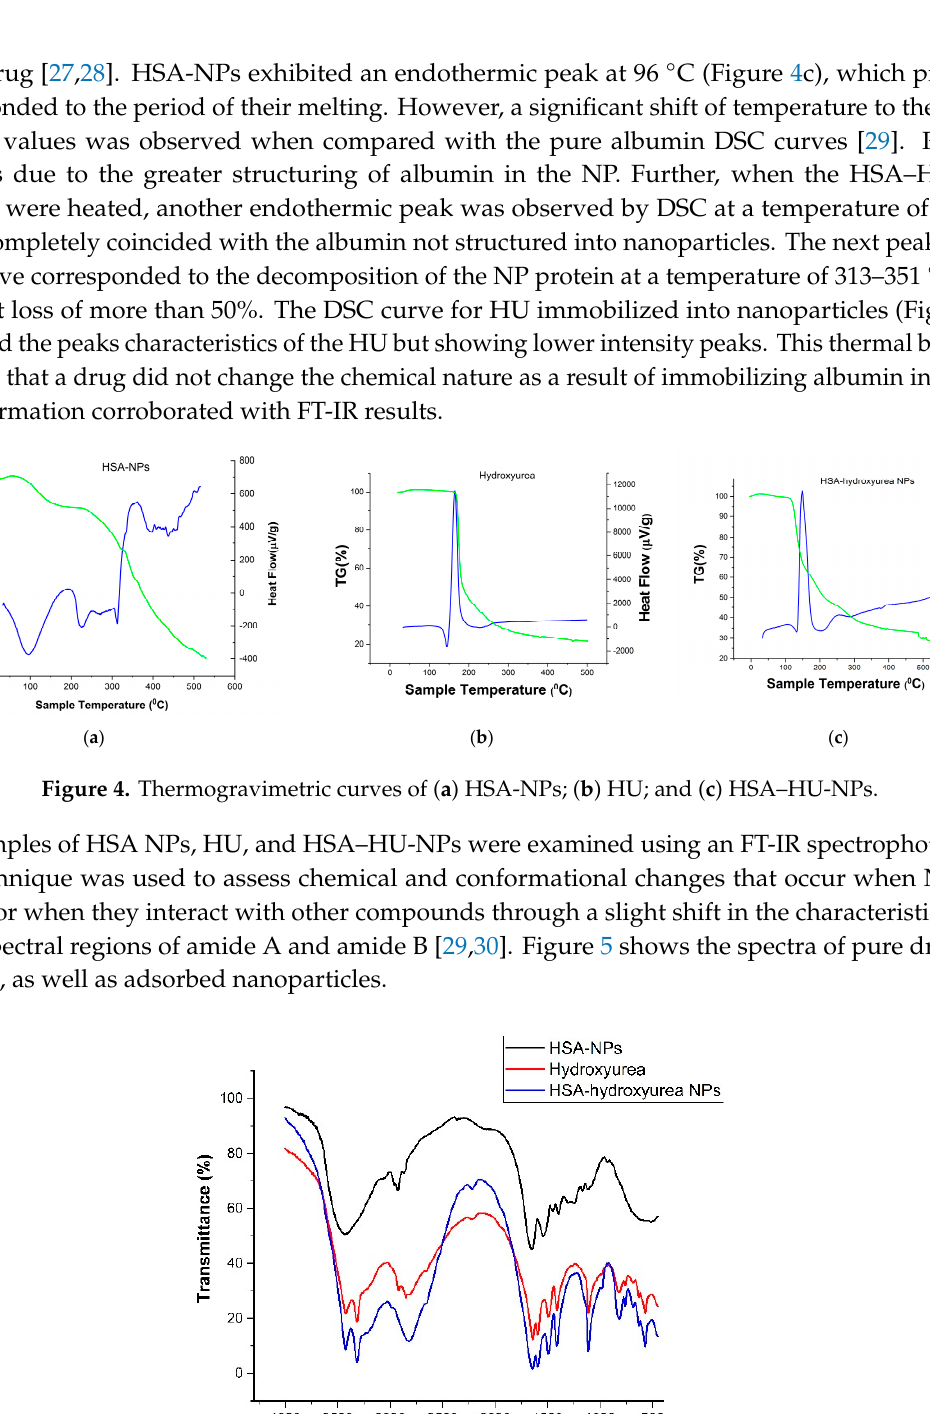
Figure 5. FT-IR spectra of hydroxyurea, HSA NPs, and hydroxyurea-loaded HSA NPs.